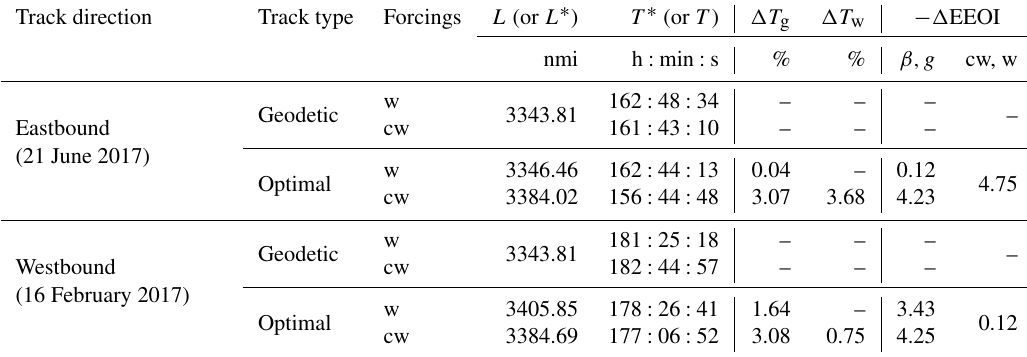
Table 5. Route length L (or L ∗ for geodetic tracks) and optimal duration T ∗ (or T for geodetic tracks) for tracks in Figs. 5–6. (cid:49)T g is the relative duration change with respect to the geodetics; (cid:49)T w is the relative duration change with respect to w-type optimal tracks. On the WGS-84 geoid, the length of the arc of GC between the endpoints is 3332.60nmi; i.e. the numerical solution overestimates it by 0.3%. In a still ocean (no currents or waves), the numerical geodetic would be sailed in 158 : 28 : 28h by a vessel with V max as in Table 4. The second header line of the − (cid:49) EEOI columns specifies the type of tracks as in Eq. (18).